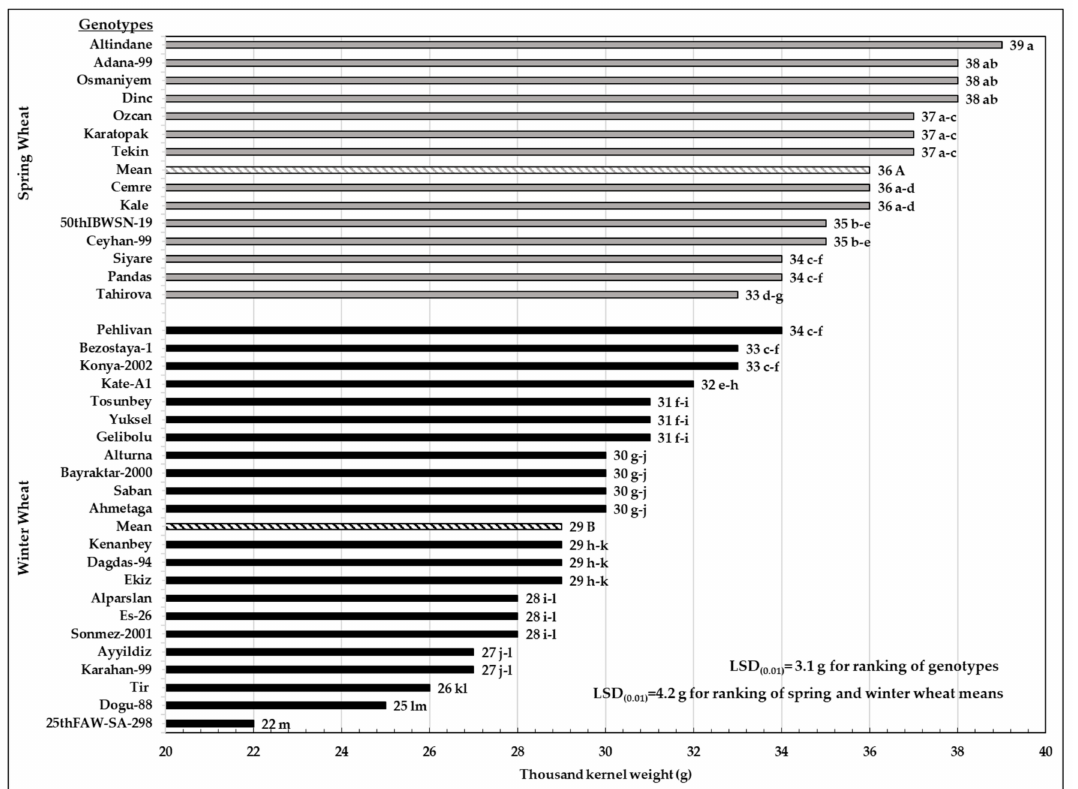
Figure 7. Comparing winter wheat genotypes with spring wheat genotypes for thousand kernel weight (g) over two cropping seasons. Genotypes with the same letter are not significantly